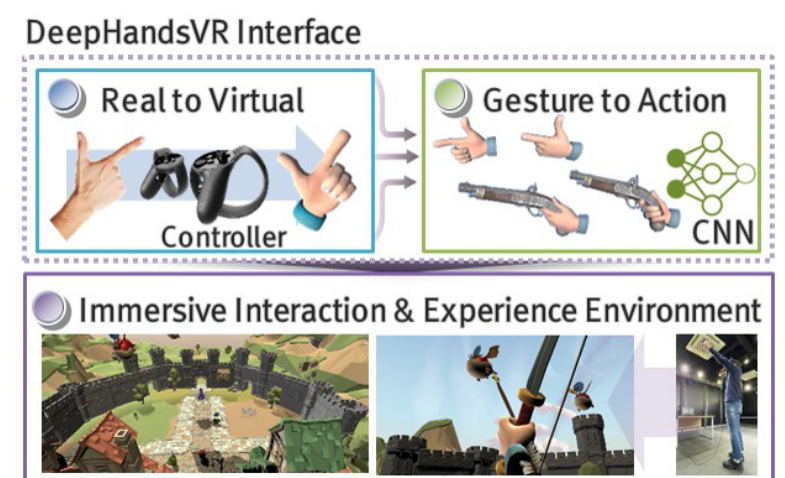
Figure 1. Processes of DeepHandsVR interface and immersive interaction.